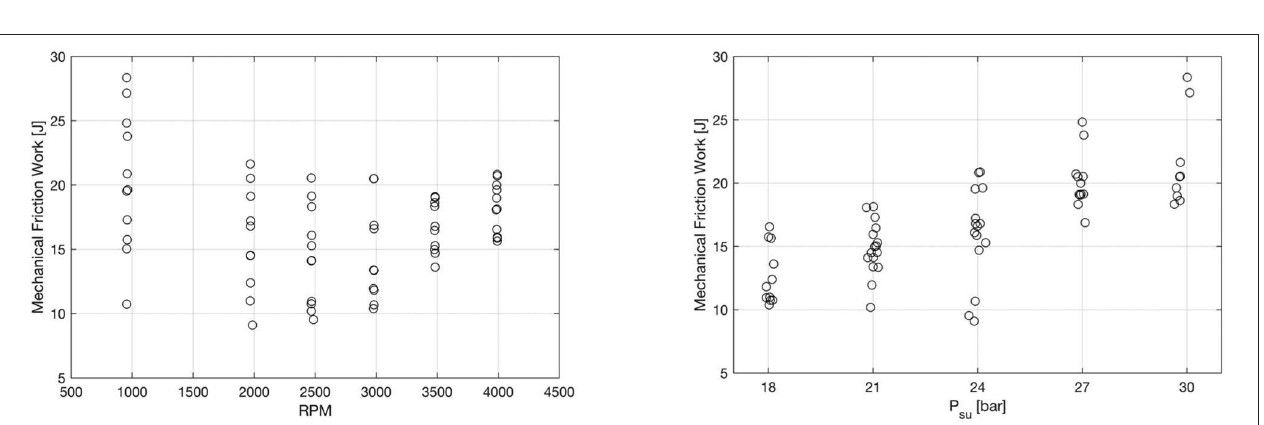
FIGURE 5 | Indicator diagrams. Opening and closing volumes are represented with green and red markers, respectively. (A) P su = 24 bar, P ex = 2.5 bar and different rotational speeds; (B) P ex = 2.5, RPM = 2,500 and different pressure ratios.